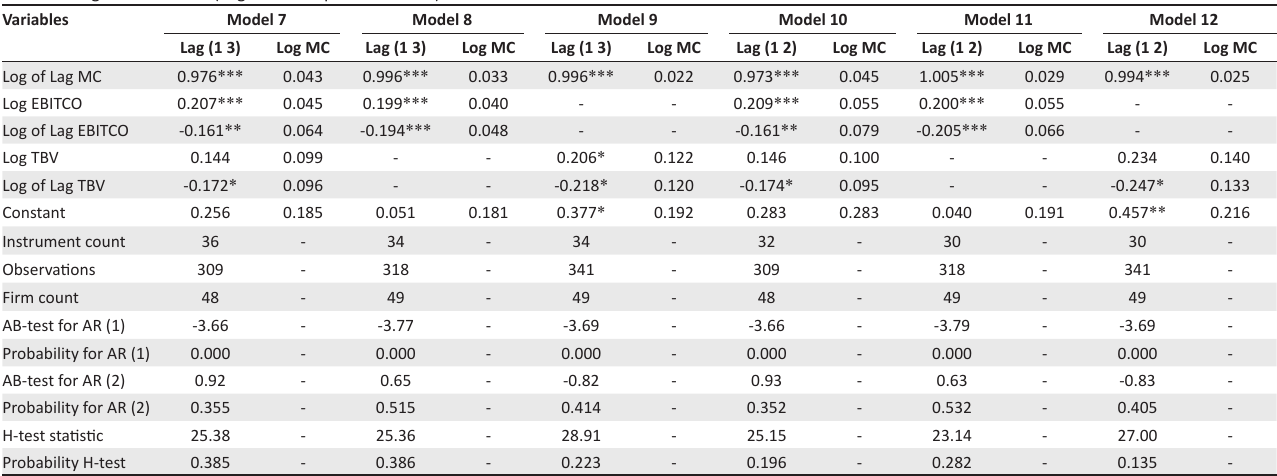
TABLE 6: Regression results (Log MC as response variable).